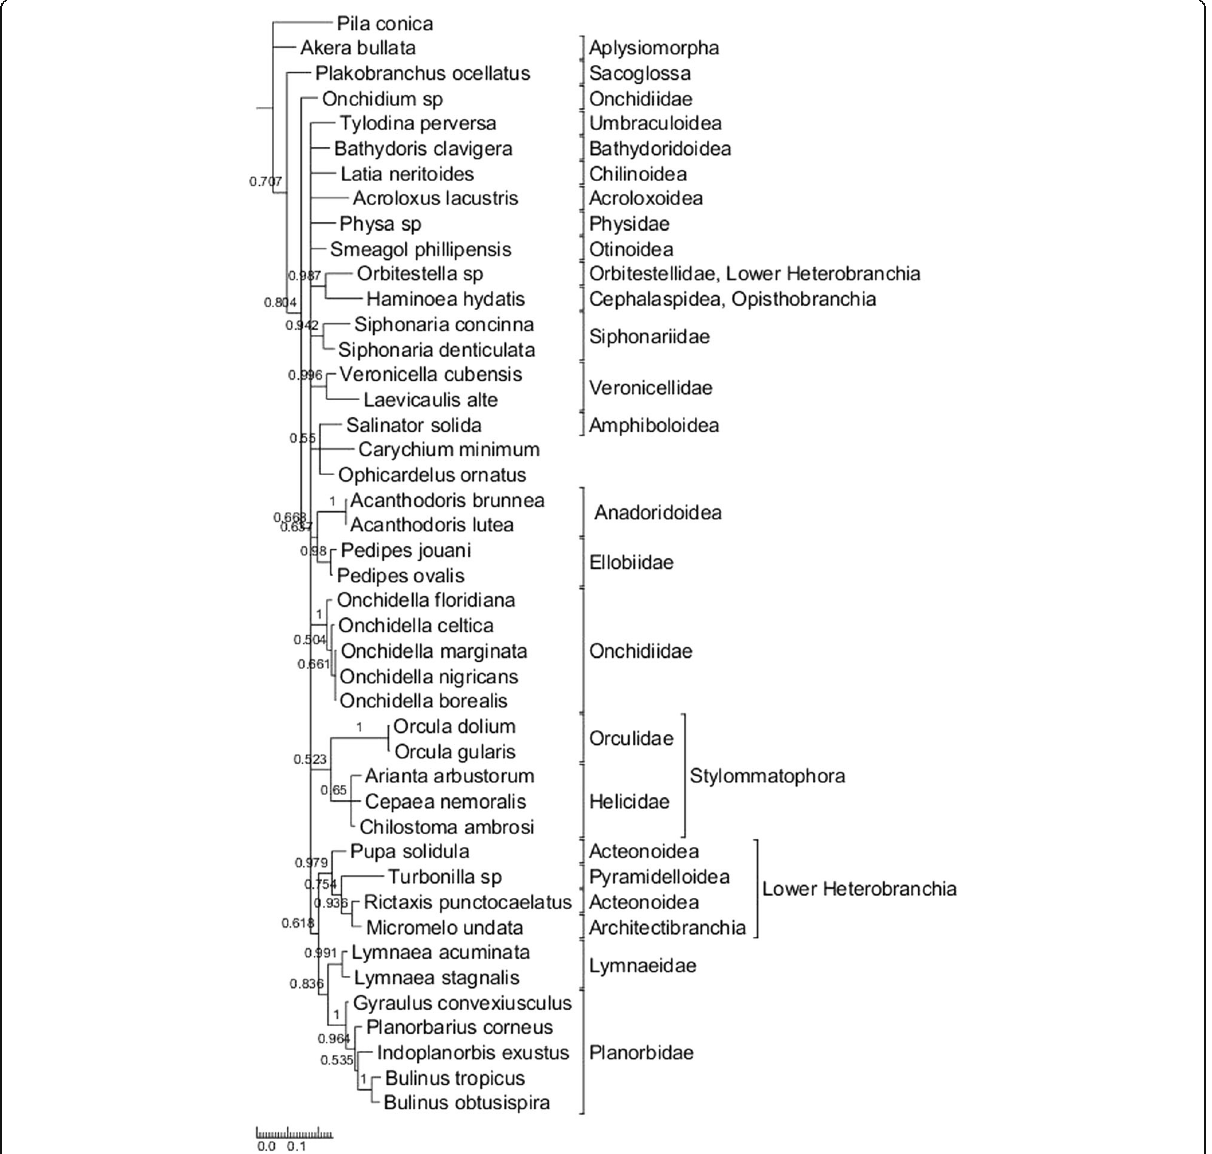
Fig. 1 Bayesian phylogram depicting the relationships among taxa on the basis of H3 (codons 1, 2 & 3 combined) gene. Indicated on the nodes are posterior probability (PP) values. Only PP values > 0.5 are